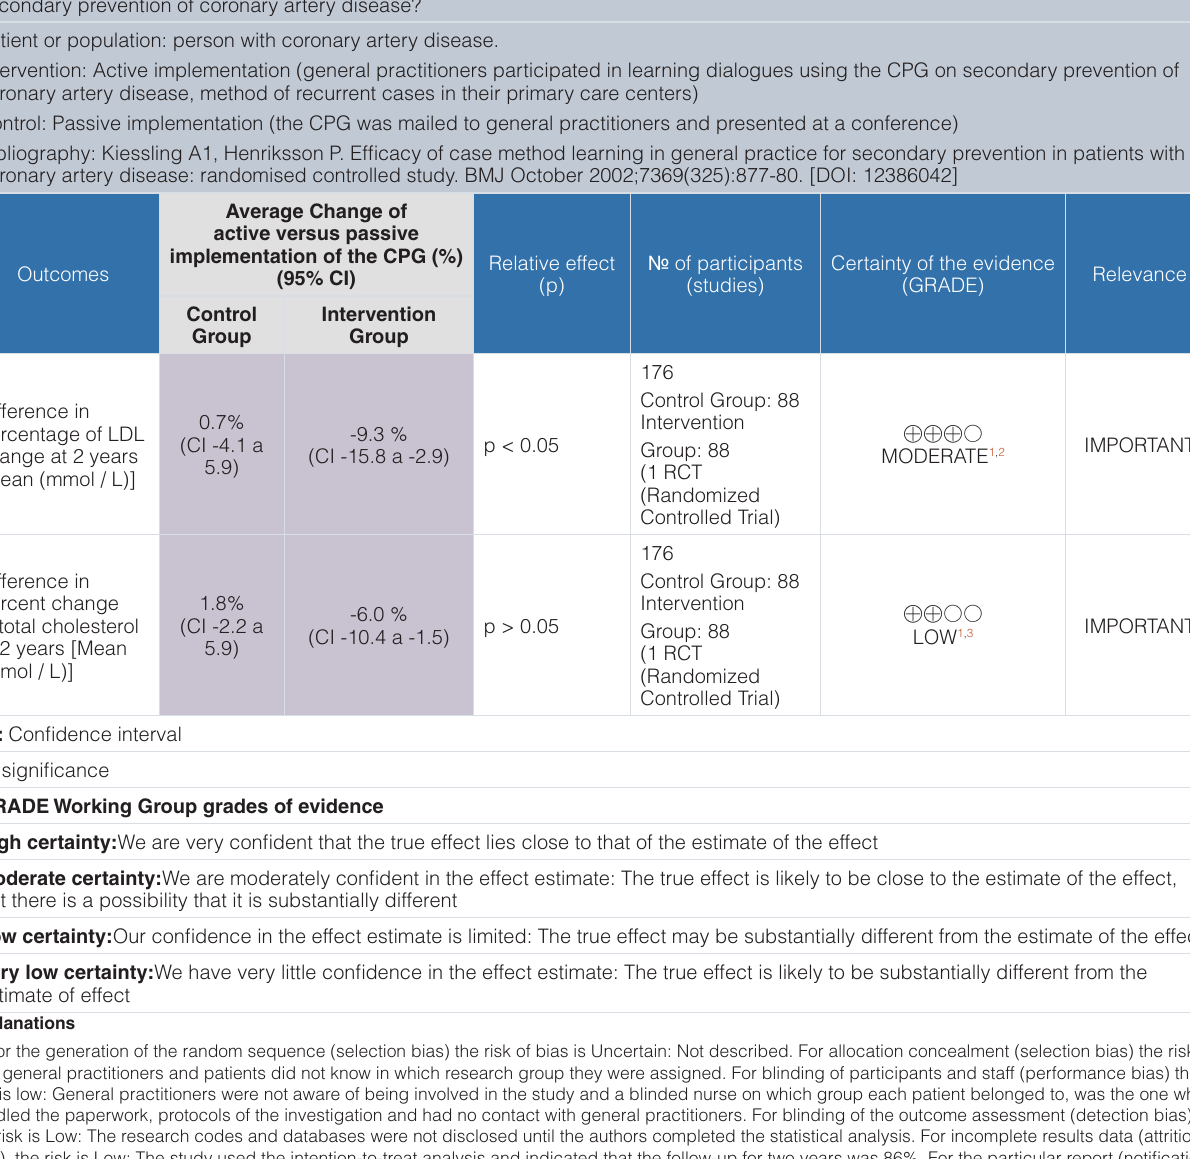
Table 2. Evaluation of the Certainty of the Evidence for the secondary prevention of coronary artery disease according to the GRADE classification: (Kiessling & Henriksson, 2002) study. Is the active implementation more effective compared to passive implementation as it was used in the control group to improve secondary prevention of coronary artery disease? Patient or population: person with coronary artery